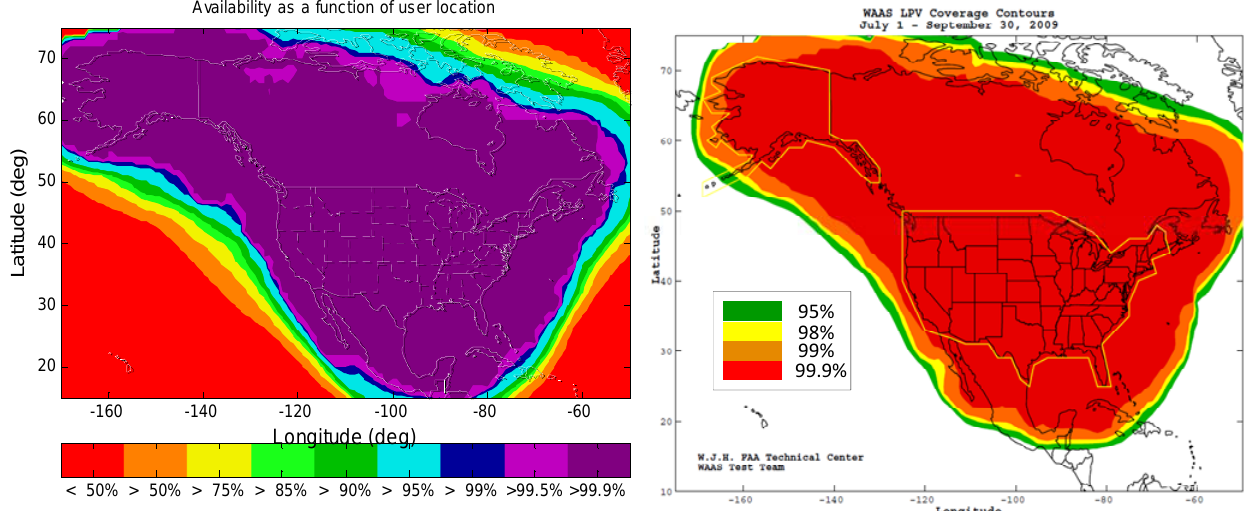
Figure 1. The 99.9% LPV availability contours of the current WAAS. The left plot is the MAAST simulation result (a 24 hour average of LPV availability using the actual almanac data of August 15th, 2009), and the right plot is the actual performance of the WAAS (a three month average of LPV availability, July 1st to September 30th,